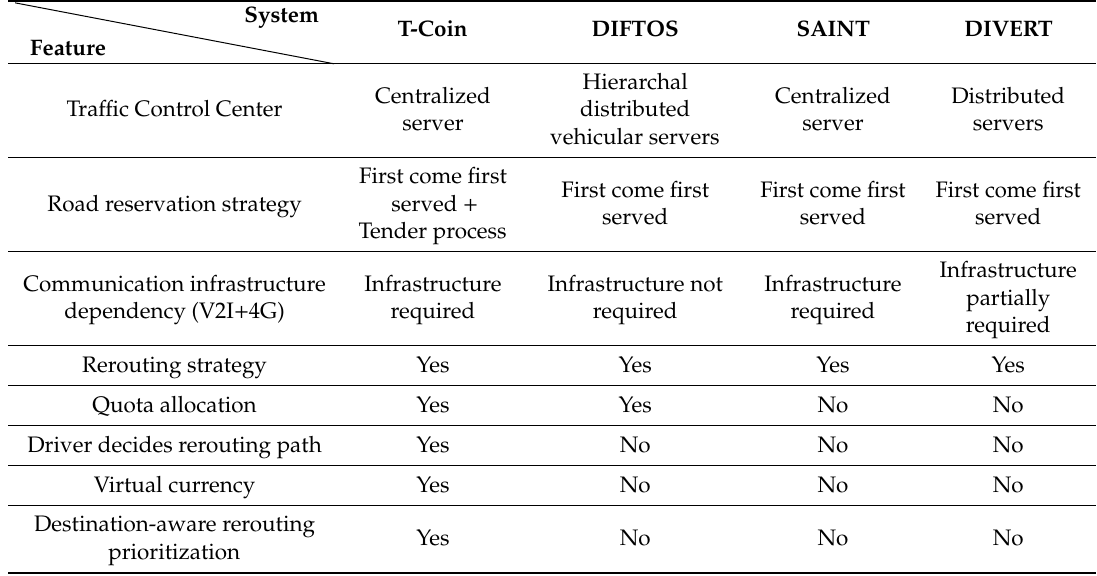
Table 1. Features comparison between T-Coin and state-of-the-art